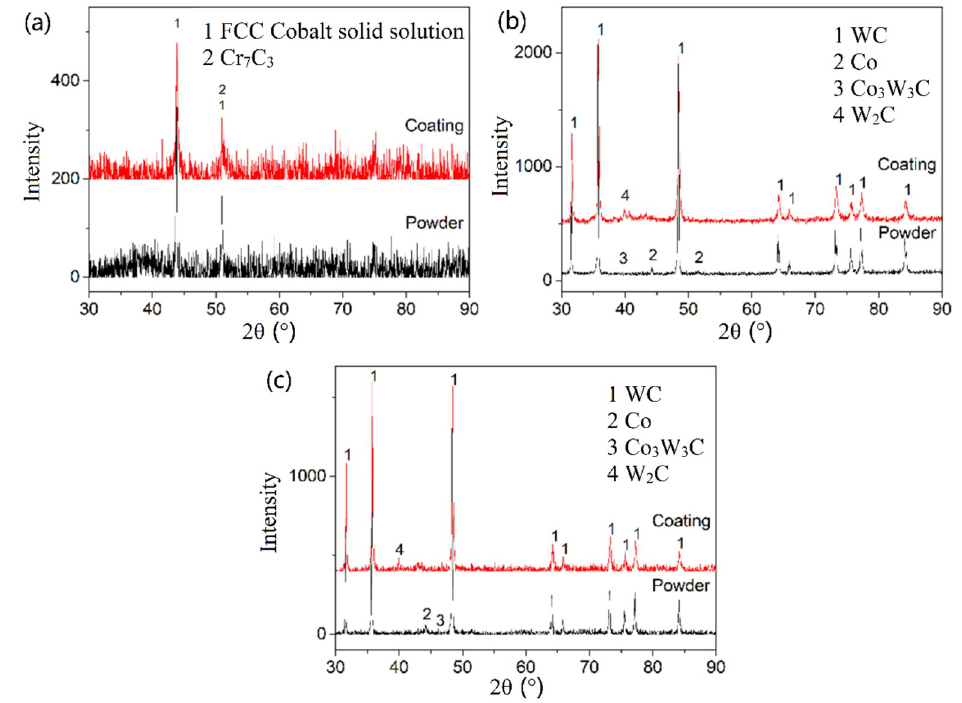
Figure 8. XRD patterns of the coatings: ( a ) Cobalt-based alloy, ( b ) WC-12Co, and ( c ) WC-17Co.